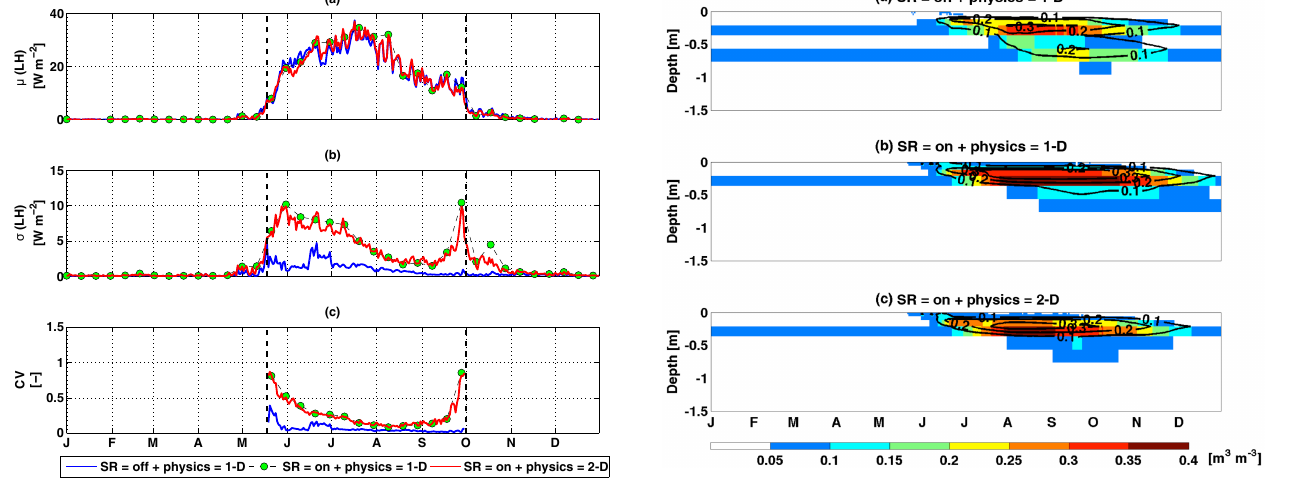
narios with and without SR (e.g., of about 25 W m − 2 in May; Fig. 10b).